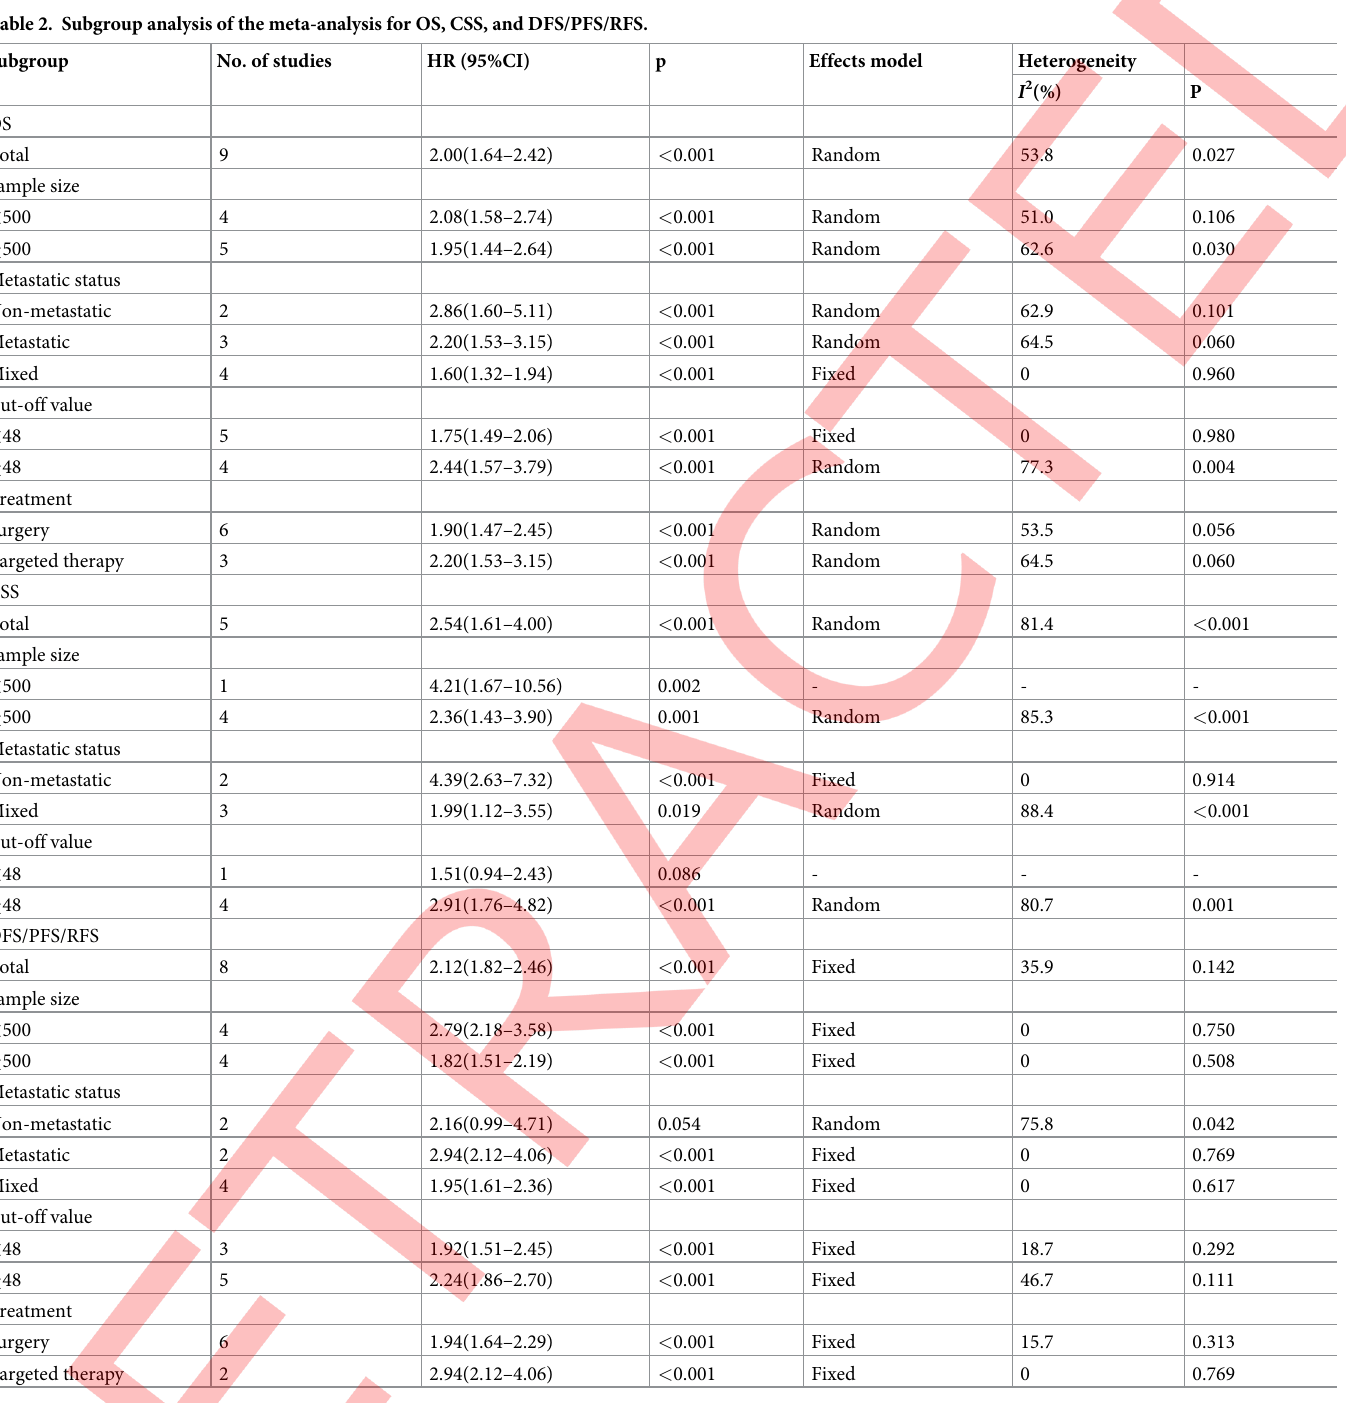
Table 2. Subgroup analysis of the meta-analysis for OS, CSS, and DFS/PFS/RFS.